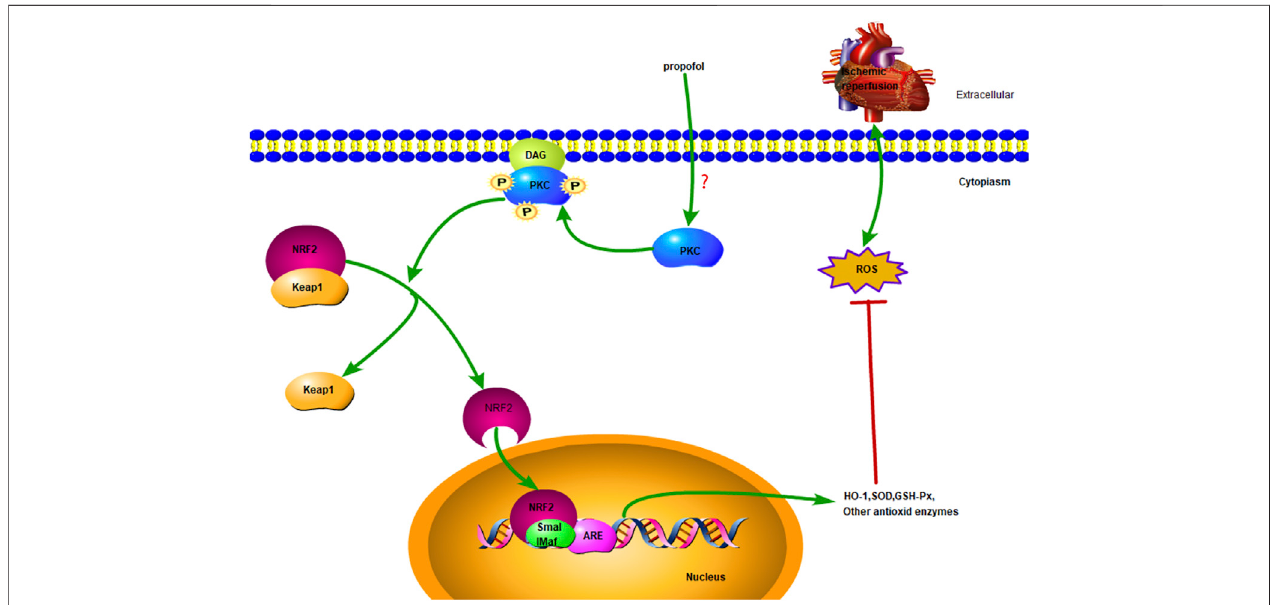
FIGURE 1 | Diagrammatic sketch Propofol protects cardiomyocytes from damage caused by H 2 O 2 or I/R oxidation through the PKC/NRF2 pathway.